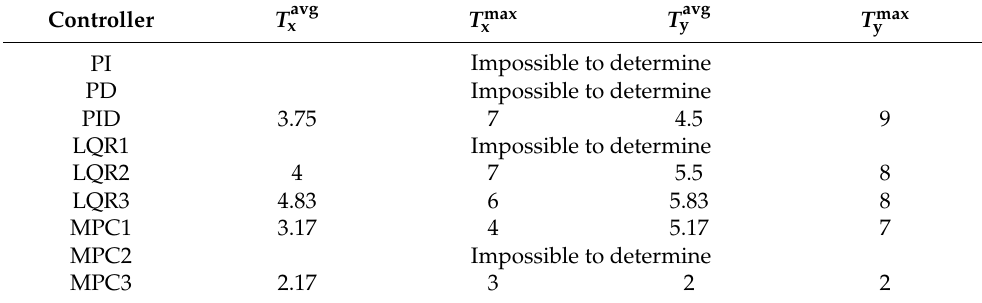
Table 4. Setting times for all compared control algorithms ( T avg x , T max x : the average and maximal setting times for the X axis, respectively; T avg y , T max y : the average and maximal setting times for the Y axis,